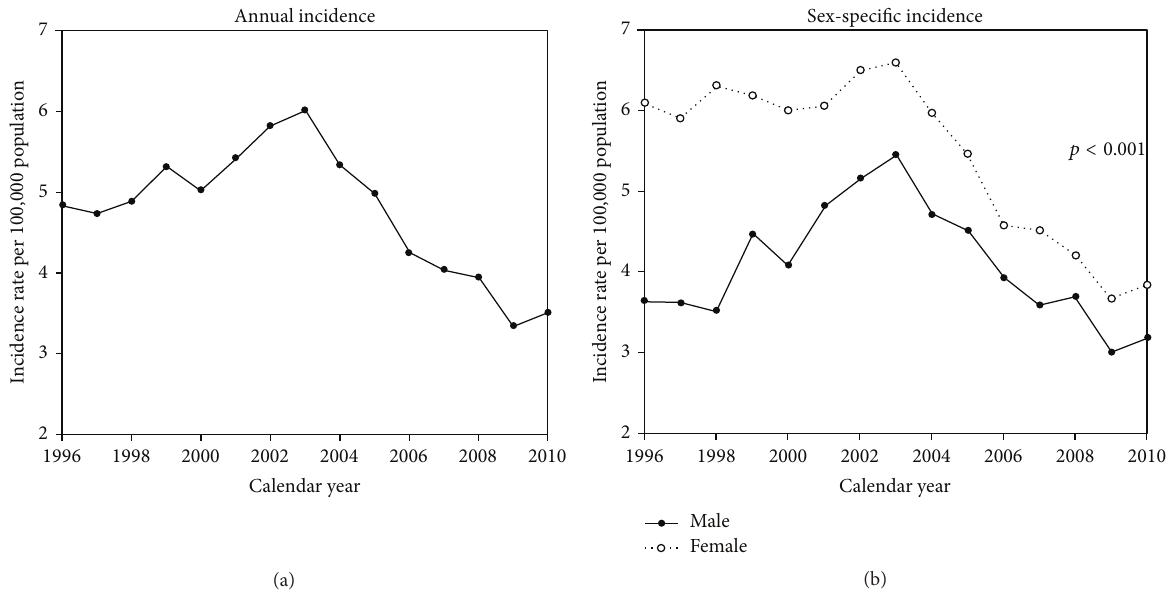
Figure 1: Incidence of corrosive injury between 1996 and 2010. (a) Annual incidence; (b) sex-specific incidence.